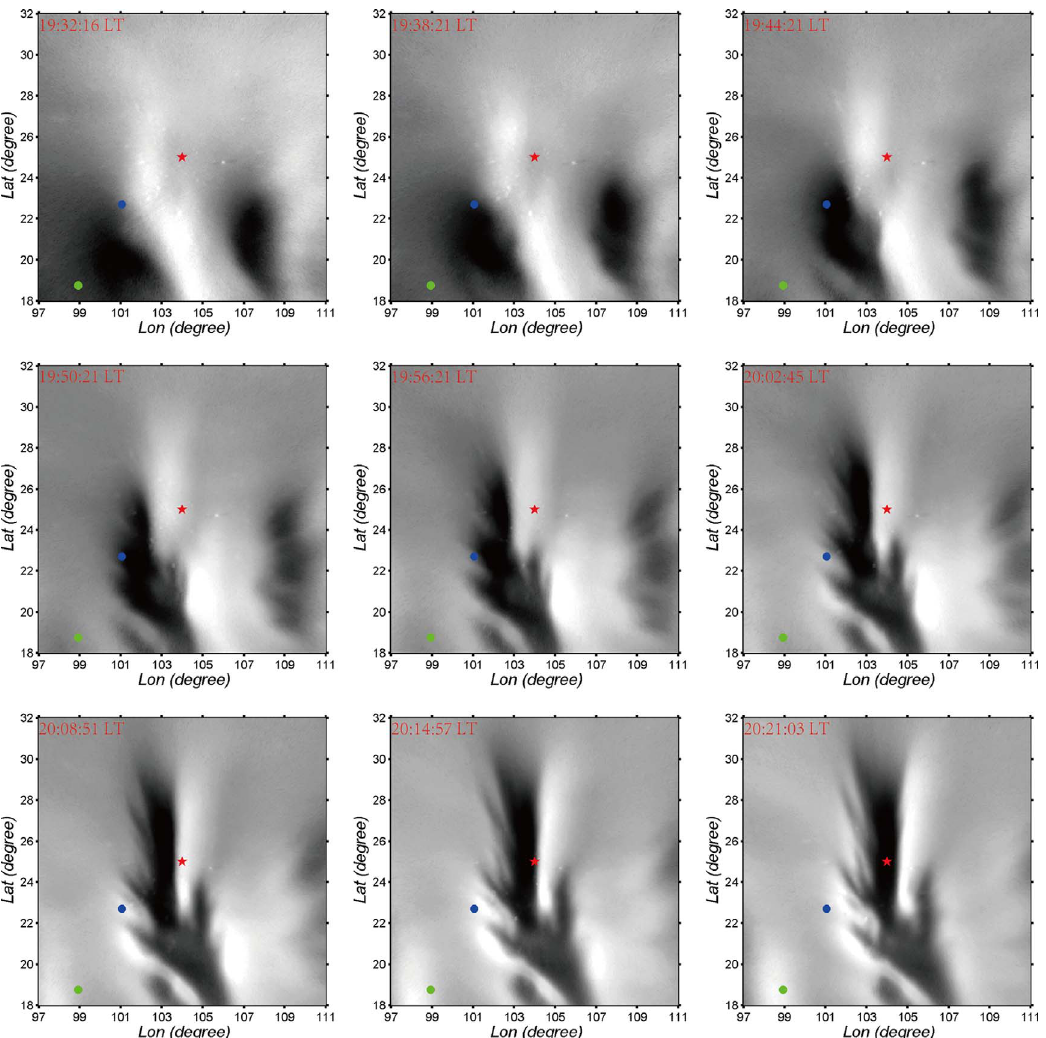
Fig. 5. Observations of airglow images from all-sky imager at Qujing station on 13 March 2015. The red star, blue, and green dots represent the all-sky imager, PUR, and CMU